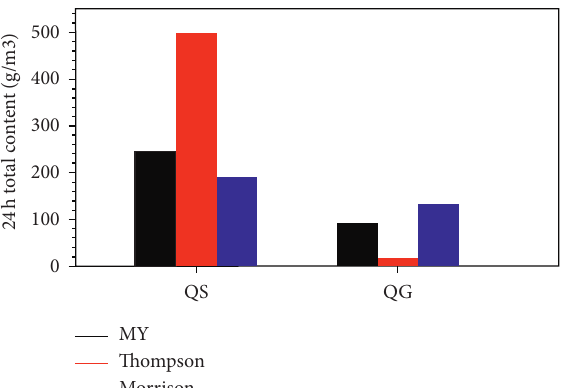
Figure 14: Vertically and domain-averaged contents of snow (QS) and graupel (QG) from three schemes in heavy rainfall areas from 1200 UTC on 1 July to 1200 UTC on 2 July